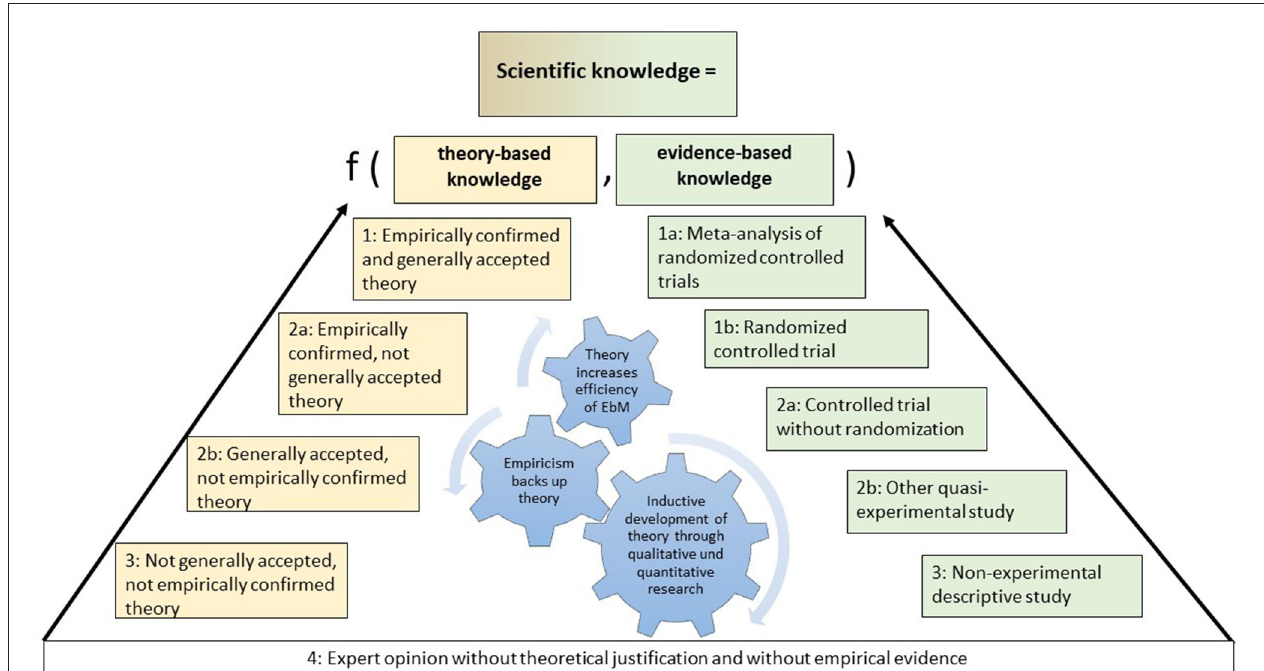
FIGURE 2 | Scientific knowledge triangle: integrating evidence-based and theory-based